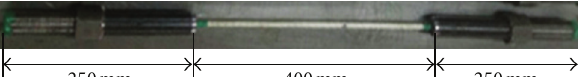
Figure 6: Interlaminar shear load-displacement behavior of HGJFRP composite bar.